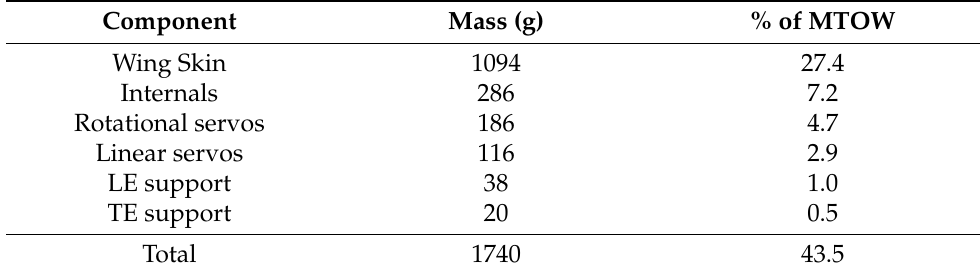
Table 4. Morphing wing mass